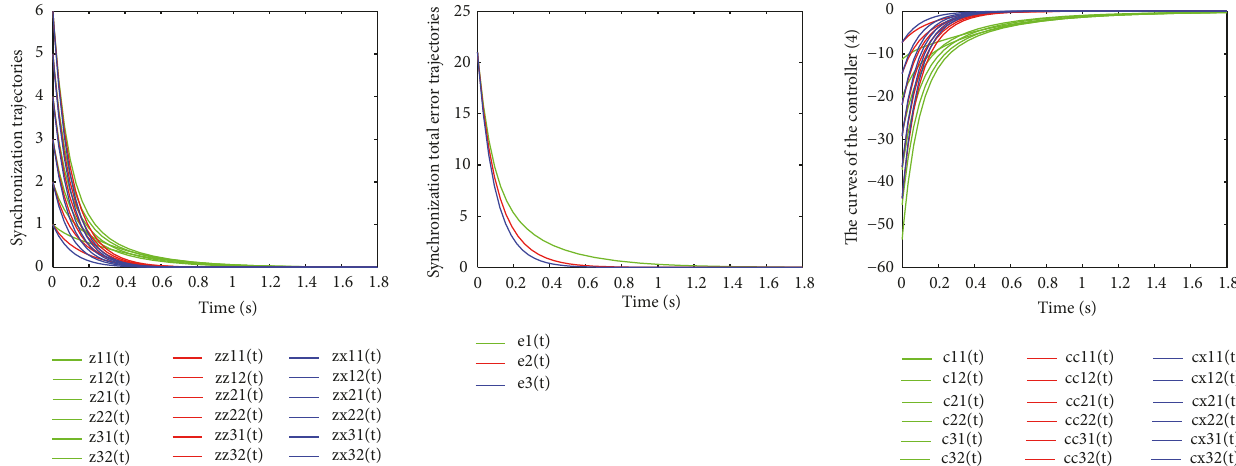
Figure 1: Synchronization trajectories, synchronization total error trajectories of network (1) with controller (4) and the curves of controller (4) for Case I of Example